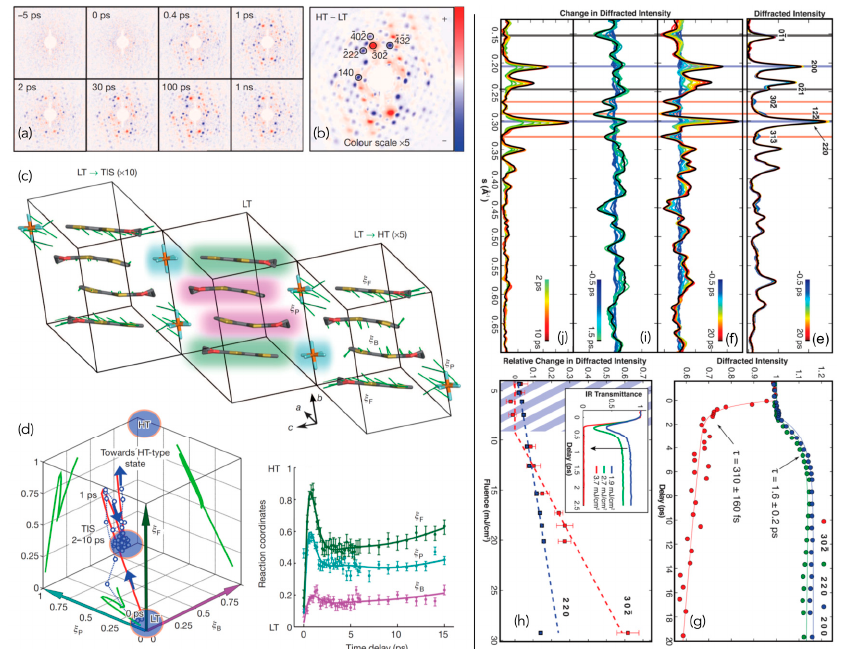
Figure 19. Movies recorded with 100-kV hybrid DC-RF FED setups. Key molecular motions leading to charge delocalization in (EDO-TTF) 2 PF 6 . ( a – c ) Photoinduced time-dependent structural changes in (EDO-TTF) 2 PF 6 . ( a ) Differences between the diffraction patterns of the photoinduced phase and the initial low temperature (LT) phase as a function of t . ( b ) Difference between the diffraction patterns of the high-temperature (HT) and LT phases. Formation of a photo-induced transient intermediate structure (TIS). ( c ) Unit cells illustrating the arrangement of EDO-TTF molecules and PF 6 counter-ions in the LT-unit cell. Major structural changes are illustrated using different background colours in the central unit cell: flat EDO-TTF moieties have a green background, bent EDO-TTF moieties have a pink background, and PF 6 anions have a cyan background. Green sticks denote the atomic displacements from the initial LT structure to the TIS (left) and the HT-type structure (right); displacements were magnified 10 and 5 times, respectively, for clarity. ( d ) Evolution of phase-transition parameter ξ in a ( ξ , ξ B , ξ P ) -Cartesian configuration space (left) and each of its components as F a function of t in the formation of TIS (right), F, B and P denote flat, bent EDO-TTF, and PF 6 moieties, respectively. Figure adapted from Reference [41] with permission from Springer Nature. Photoinduced metal-like phase of monoclinic VO 2 . ( e – e ) Photoinduced time-dependent structural changes: ( e ) ackground-subtracted FED data from t = 0 to 20 ps. Vertical lines indicate different groups of reflections that are relevant to monitor the monoclinic (M1) to rutile (R) photoinduced structural transition. ( f ) Overall differences in the diffraction intensities from –0.5 to 20 ps. ( g ) Time-resolved diffraction intensity changes showing fast (~300 fs) and slow (~1.6 ps) dynamics. ( h ) Fluence dependence of the fast and slow signal amplitudes as measured for two selected Bragg reflections; inset, transient transmittance measurements. ( i ) Diffraction difference spectrum for the fast dynamics from –0.5 to 1.5 ps. The change in diffracted intensity is plotted with respect to –1 ps. ( j ) Diffraction intensity difference for the slow dynamics. The change in diffracted intensity from 2 to 10 ps (referenced to 2 ps) is shown. Figure adapted from Reference [189] with permission from Science